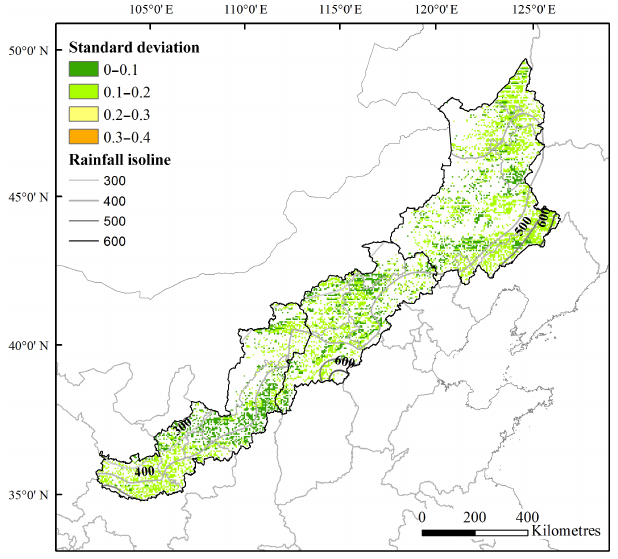
Figure 10. Standard deviation of spring maize yield loss ratio from 1966 to 2011.